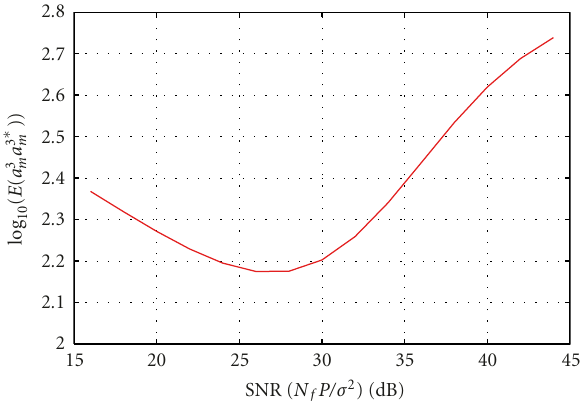
Figure 5: E ( a m 3 a m 3 ∗ ) as a function of SNR for the channel realization CR-1 given in Table 1 ( N f = 64 and RFO = 0.05, and symbols are from 4-QAM constellation with P = 1).